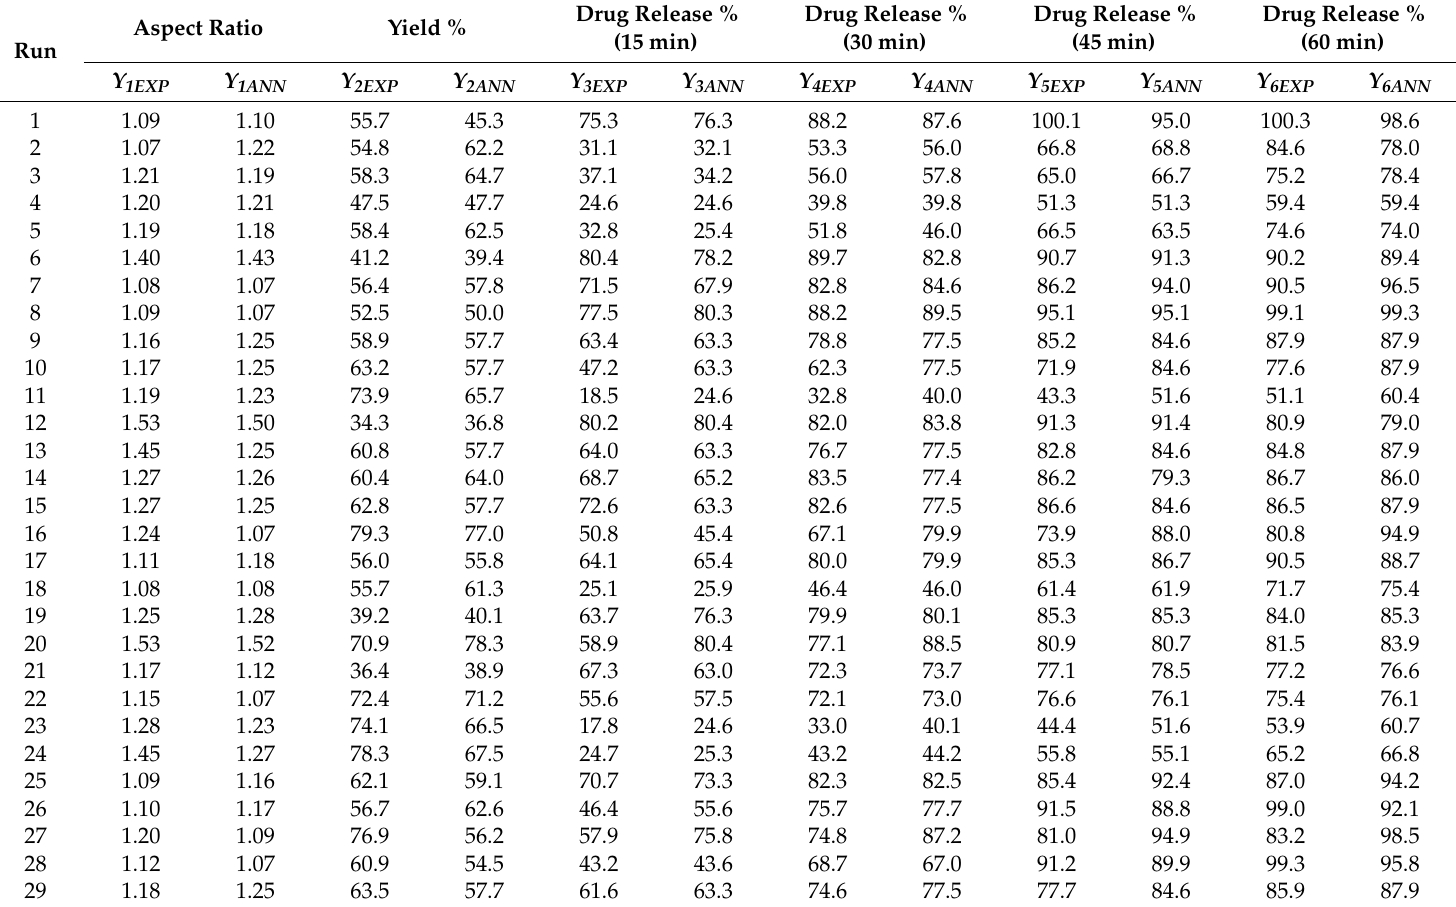
Table 3. Experimental and ANN-predicted